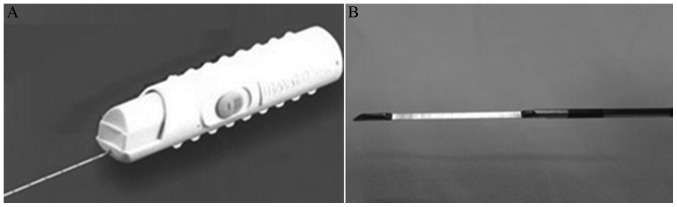
(A) Bard® Max-Core® 18 G biopsy needle; (B) top slide locked back and biopsy sample notch exposed.